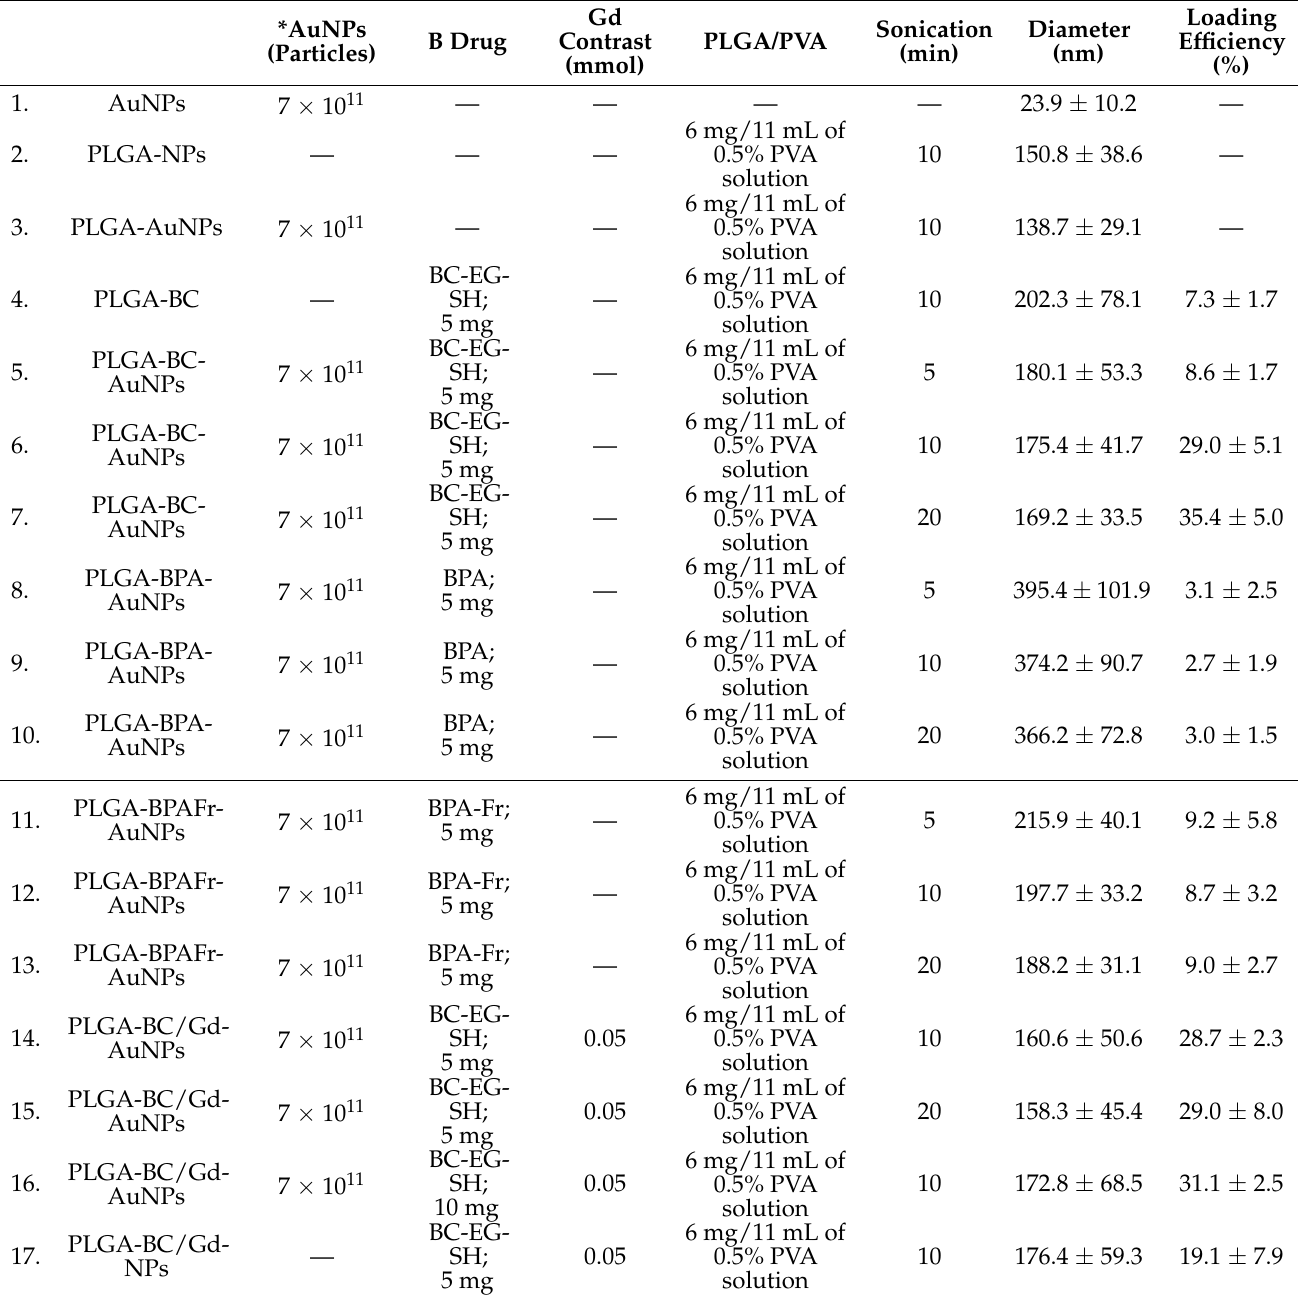
Table 1. The formulation and physical properties of various